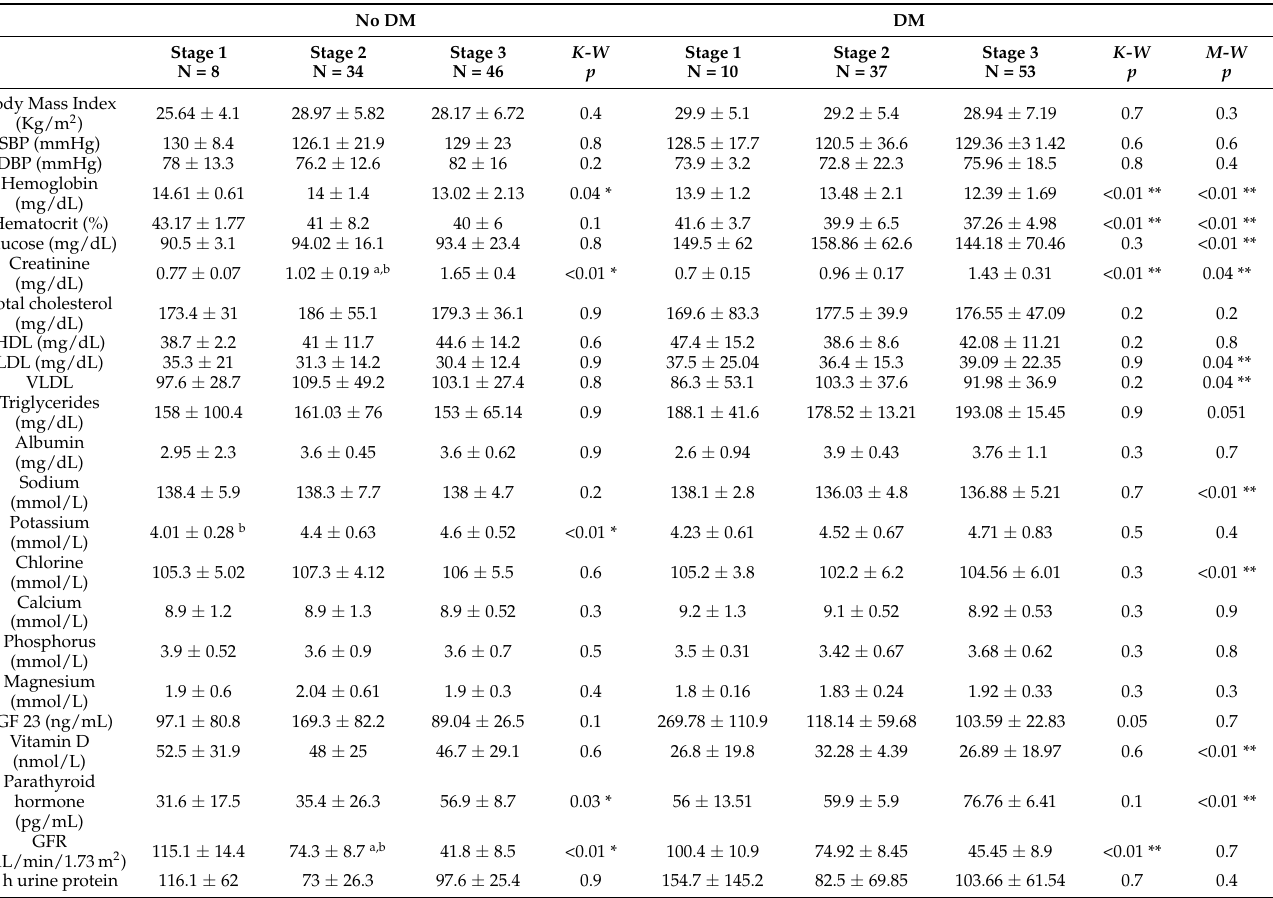
Table 1. Clinical and biochemical